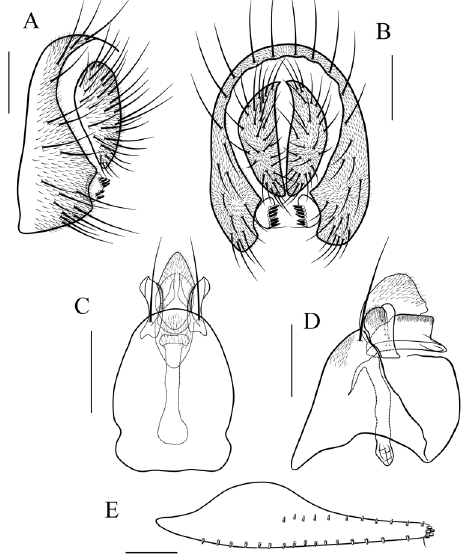
Figure 16. Scaptodrosophila protenipenis sp. n. A, B epandrium, surstylus and cercus (lateral and posterior views) C, D hypandrium, parameres, gonopods, aedeagus and aedeagal apodeme (ventral and lateral views) E oviscapt (lateral view). Scale bars 0.1 mm.